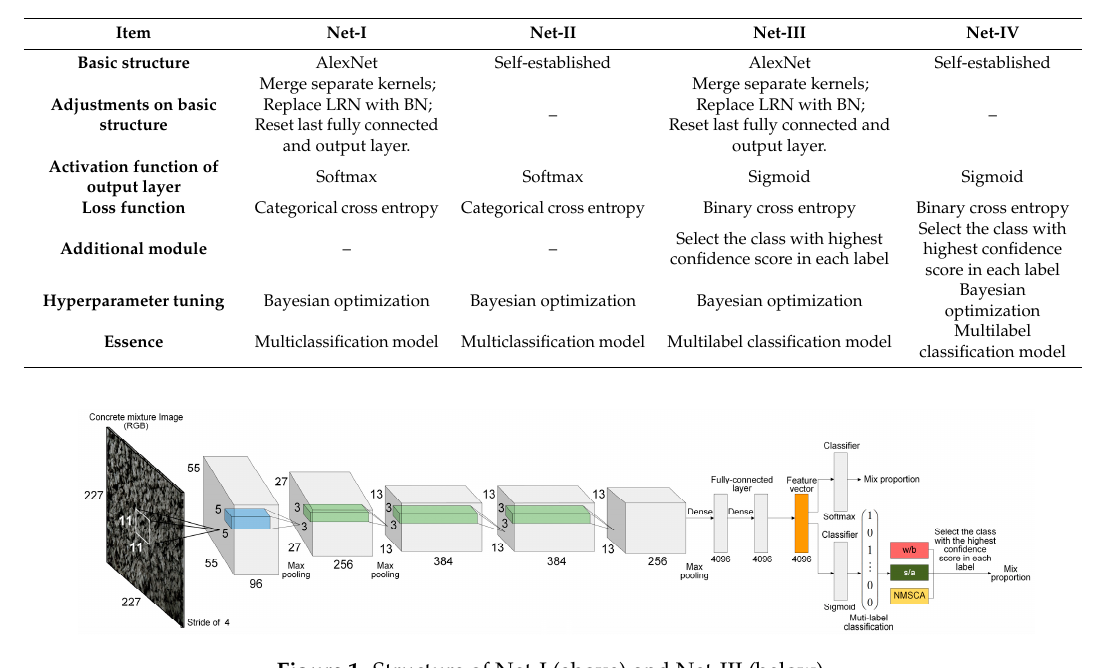
Table 9. Adjustments or improvements of four CNN models.